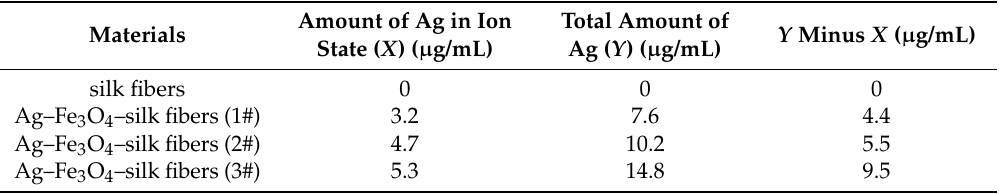
Table 1. The amount of Ag released into the nutrient media from the Ag–Fe 3 O 4 –silk fiber nanocomposites, as measured by ICP-MS.